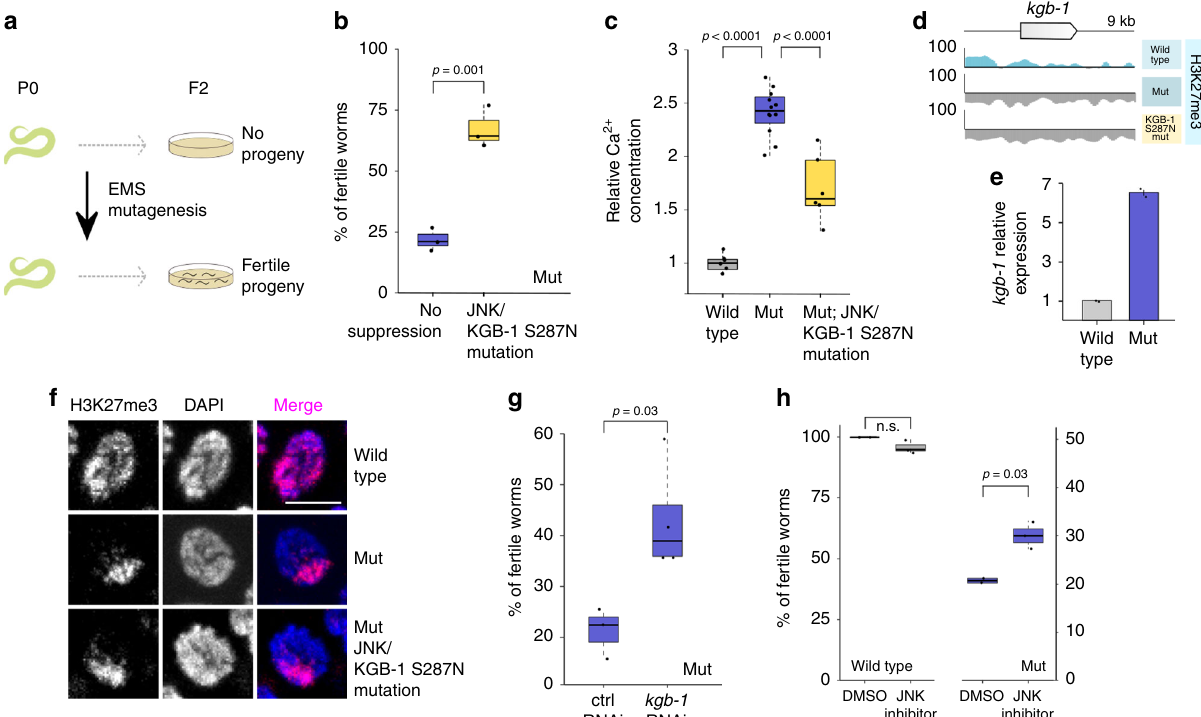
Fig. 5 JNK inhibition counteracts phenotypes caused by H3.3K27M mutation. a Cartoon showing experimental setup for the random EMS mutagenesis. P0 worms were mutagenized, and individual F2 worms were screened for fertility that was maintained for several subsequent generations at 25 °C. b Fertility boxplot for H3.3K27M mutant (mut) worms with (yellow) and without (blue) KGB-1/JNK S287N suppressor mutation. N = 3 for all conditions. c Boxplot showing relative Ca 2 + concentration in gonads of wild type (gray), mut (blue) and mut; KGB-1/JNK S287N (yellow). Concentration in wild type was set as one and used as a reference for the other strains. N = 6 for wt, N = 12 for mut, N = 6 for mut; KGB-1/JNK S287N. d Genome browser view showing H3K27me3 levels around the kgb-1 gene in wild-type, mut and mut; KGB-1/JNK S287N worms. e Bar plot showing the kgb-1 expression levels in wild-type and mut germ lines based on RNA-seq (bottom). Error bars are standard deviations. f H3K27me3 staining in wild type, mut and mut; KGB-1/JNK S287N. Scale bar represents 5 µ m. g Fertility boxplots of mut worms upon treatment with control (left) or kgb-1 /JNK (right) RNAi. N = 3 for control, N = 4 for kgb-1 RNAi. h Fertility boxplots of wild-type (gray) and mut (blue) worms upon treatment with DMSO or JNK inhibitor SP600125. N = 3 for inhibitor and N = 2 for DMSO treatment. Signi fi cance was tested for using student ’ s t